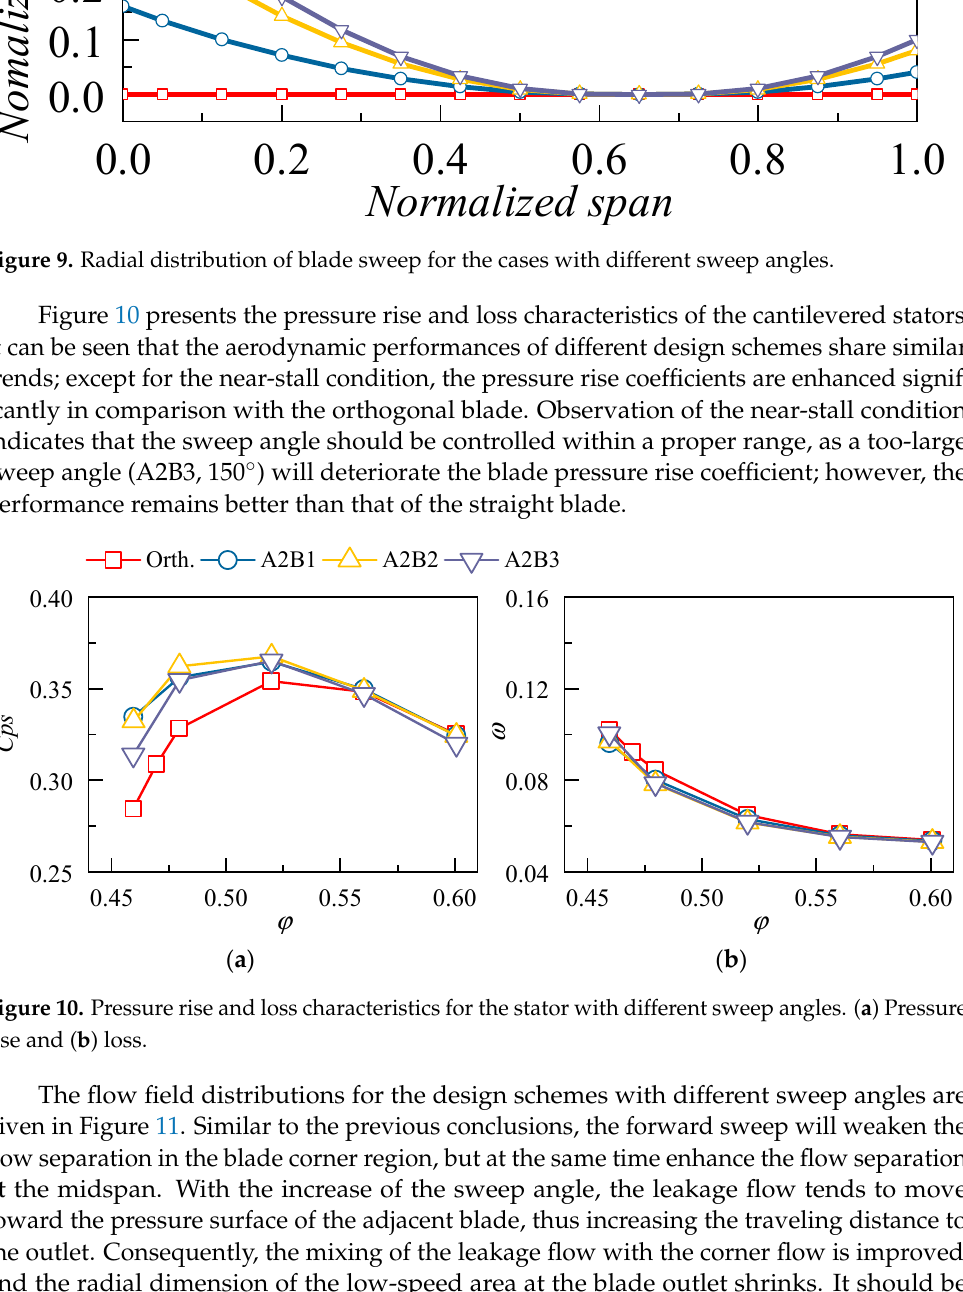
Figure 10. Pressure rise and loss characteristics for the stator with different sweep angles. ( a ) Pres-